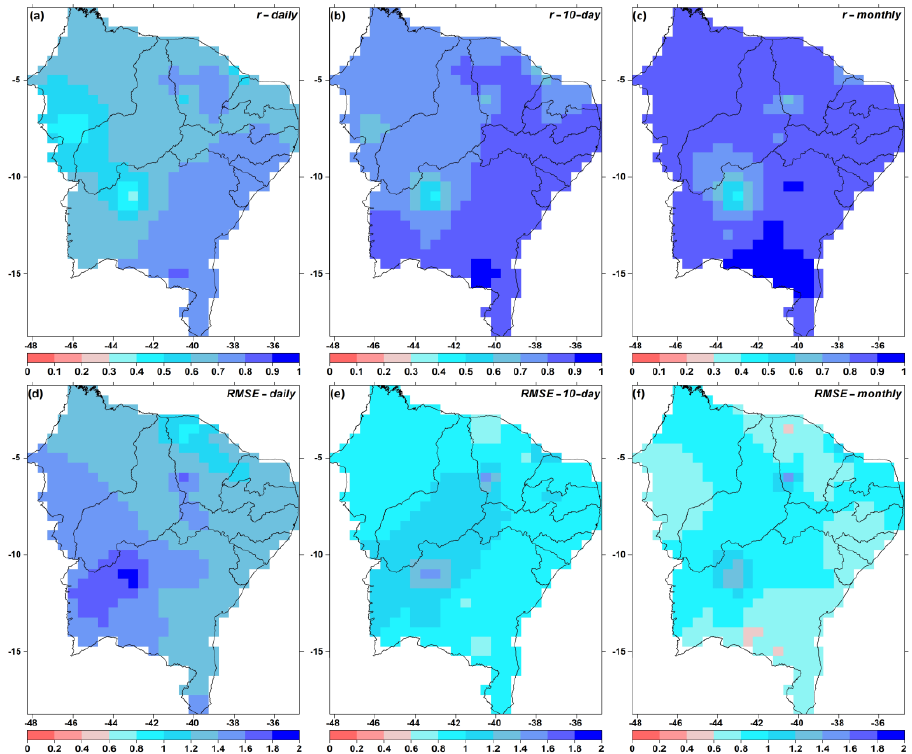
Figure 5. Correlation maps for temperature between imputed and observed data on the daily ( a ), 10-day ( b ) and monthly ( c ) timescales; and RMSE (°C) on the daily ( d ), 10-day ( e ) and monthly ( f ) time-scales.